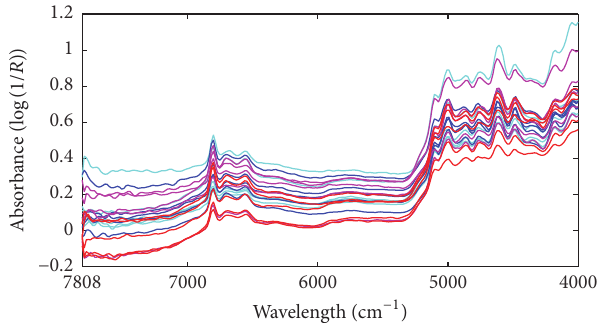
Figure 4: The pixel spectra corresponding to the 𝐶 𝑖 maximum of melamine for Set B samples: 5 g kg −1 (cyan), 10g kg −1 (blue), 25g kg −1